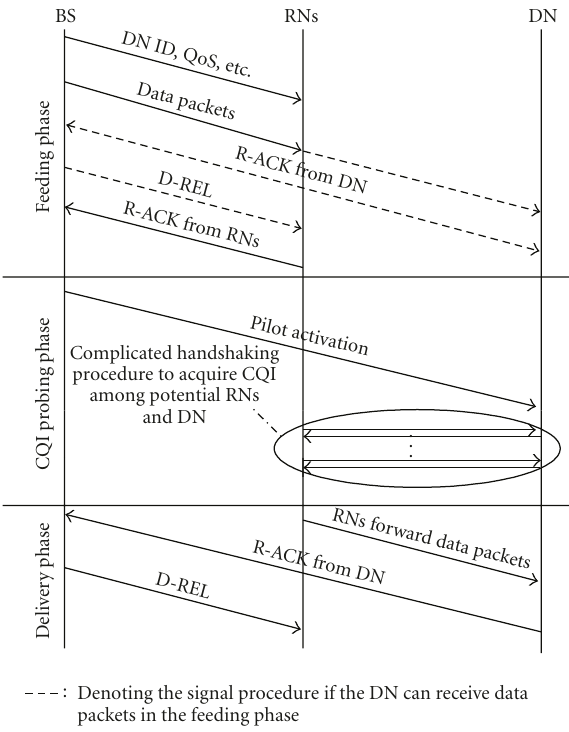
Figure 3: Conventional IMDR protocol